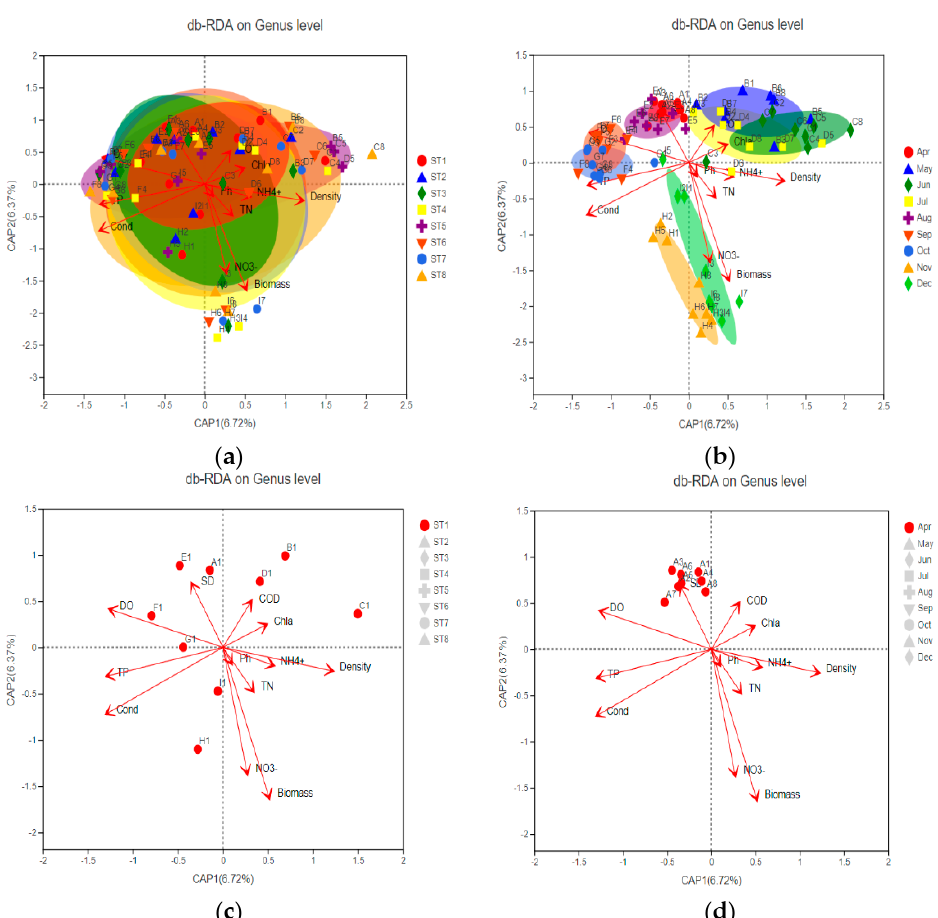
Figure 6. db-RDA analysis of the community structure and environmental factors of bacterioplankton in the reservoir based on spatial ( a ) and temporal ( b ) groups. db-RDA analysis of the ST1 bacterial community structure and environmental factors ( c ), db-RDA analysis of the bacterial community structure and environmental factors in April ( d ).